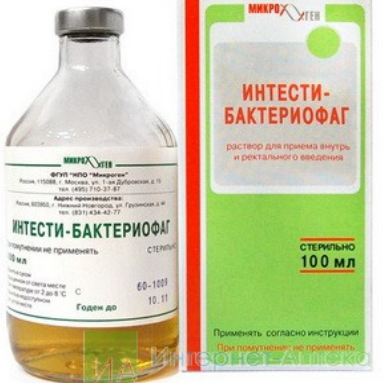
Figure 1. Commercially produced mix of phages “Intesti” (ImBio Nizhny Novgorod,